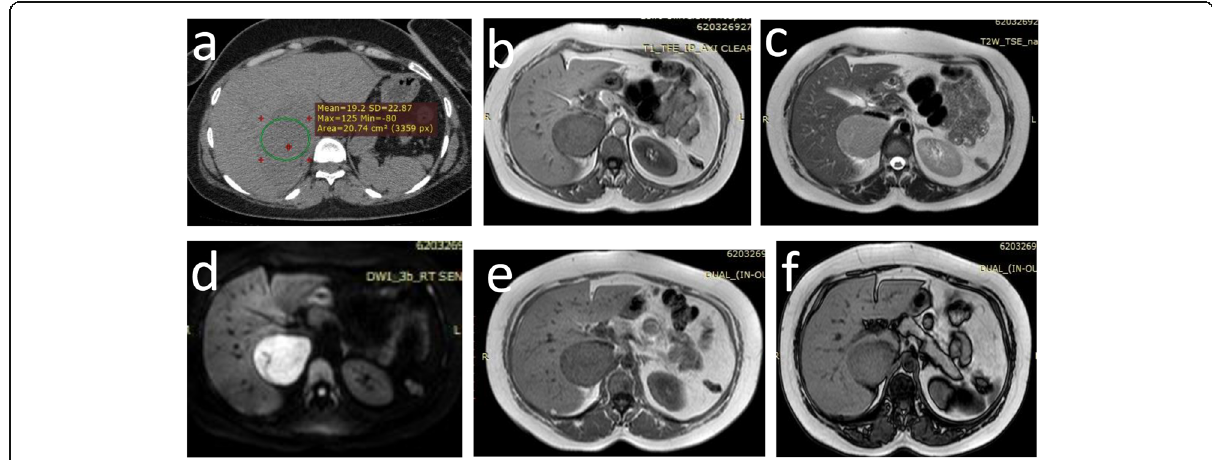
Fig. 7 A 63-year-old male patient complaining of occasional right upper abdominal pain of long duration. a CECT of the abdomen showing right thin walled cystic lesion of the right suprarenal gland measuring 7 cm × 6 cm in maximum axial dimensions with no solid component or significant mural enhancement with internal homogenous fluid content 5 HU. MRI abdomen adrenal protocol showing right suprarenal cystic lesion eliciting low TI signal ( b ) and bright T2 signal ( c ). No diffusion restriction ( d ) eliminating the possibility of an abscess. No signal drop in the opposed phase image (f) in relation to in phase image ( e ). Diagnosis: right simple suprarenal cyst, no further evaluation was required